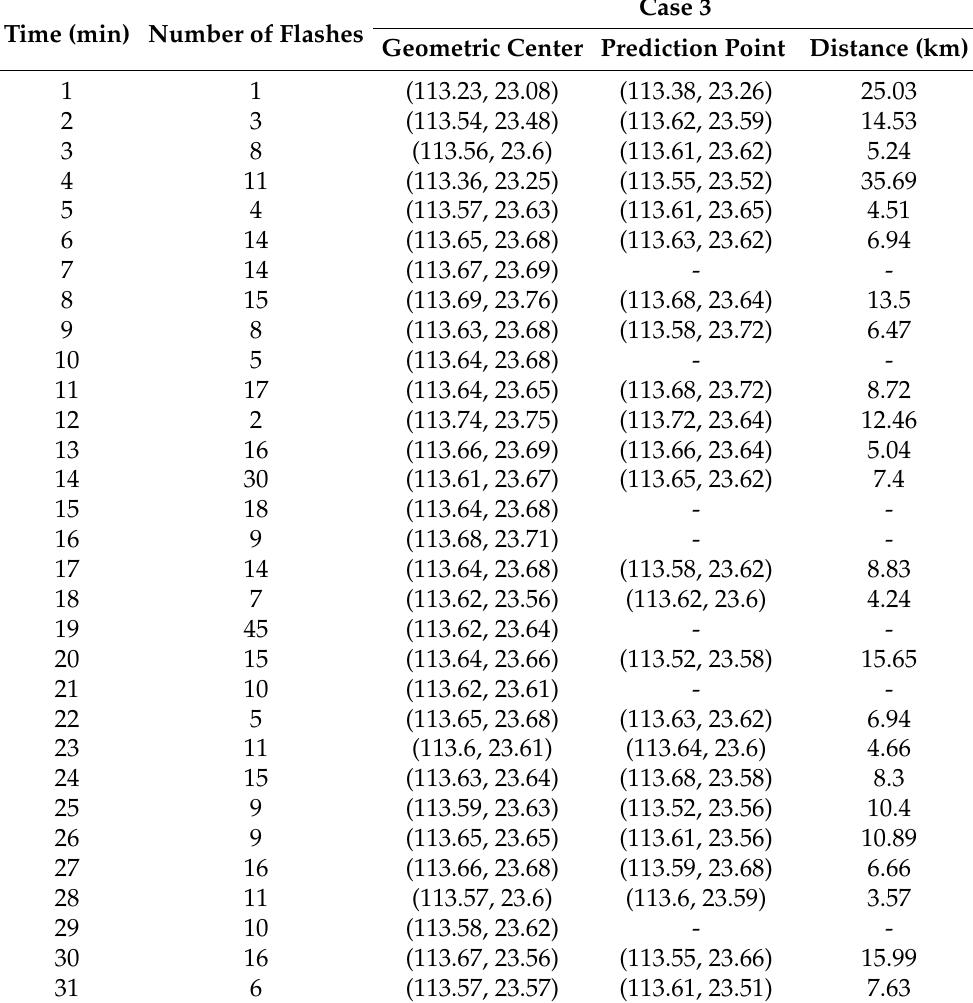
Table 6. Real lightning events and the predicted results given by the system per minute in Case